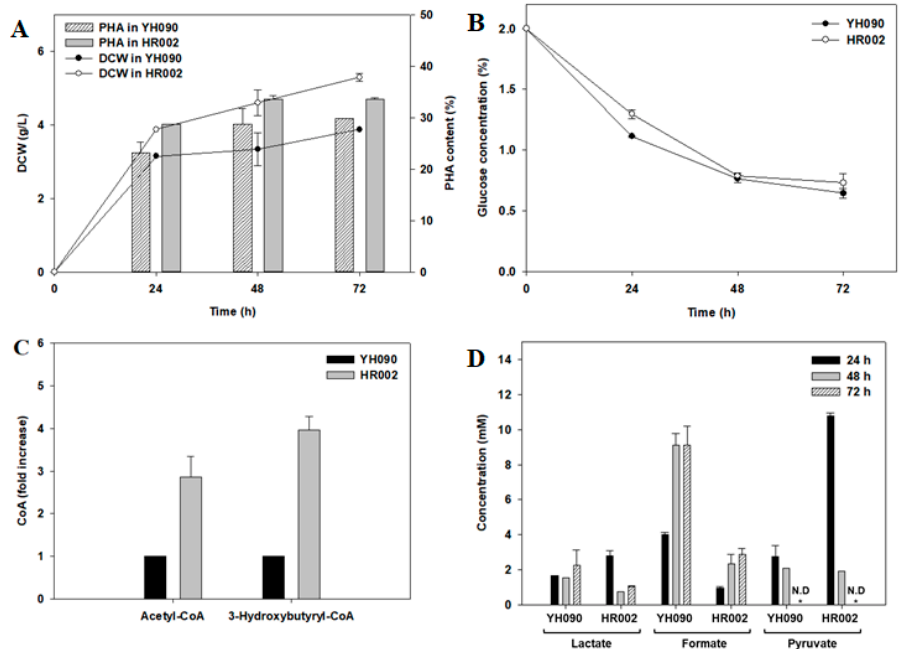
Figure 3. Polyhydroxybutyrate (PHB) production in engineered E. coli over time: ( A ) DCW (dry cell weight, g/L) and PHB content (wt/wt %); ( B ) glucose concentration (g/L); ( C ) relative amount of CoA metabolites (fold increase); and ( D ) secreted organic acid concentration [40]. Cell cultivation was conducted for 72 h in M9 minimal medium containing 2% glucose as a sole carbon source. CoA metabolites were measured at 6 h. Error bars represent the standard deviations of two replicates.